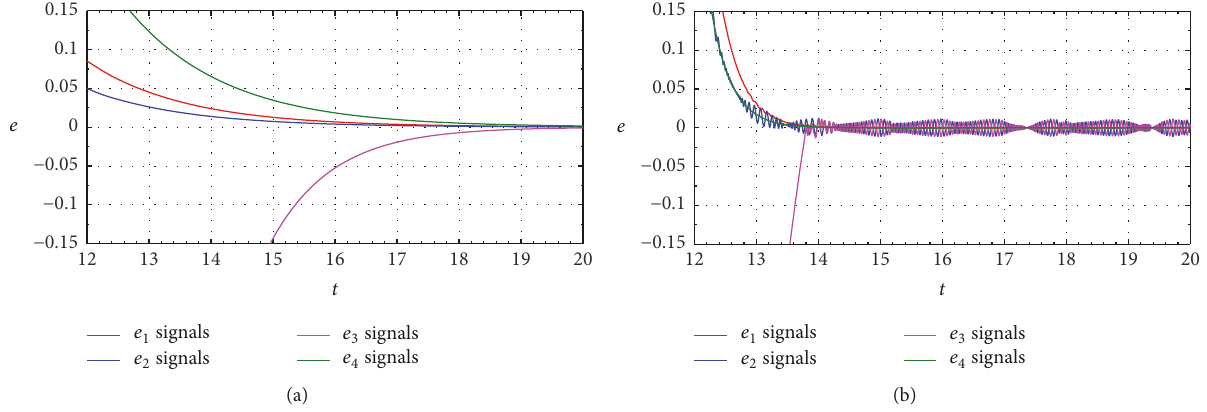
Figure 6: Synchronization errors between 𝑡 ≥ 12 and 𝑡 ≤ 20 : (a) active controllers and (b) sliding mode controllers.